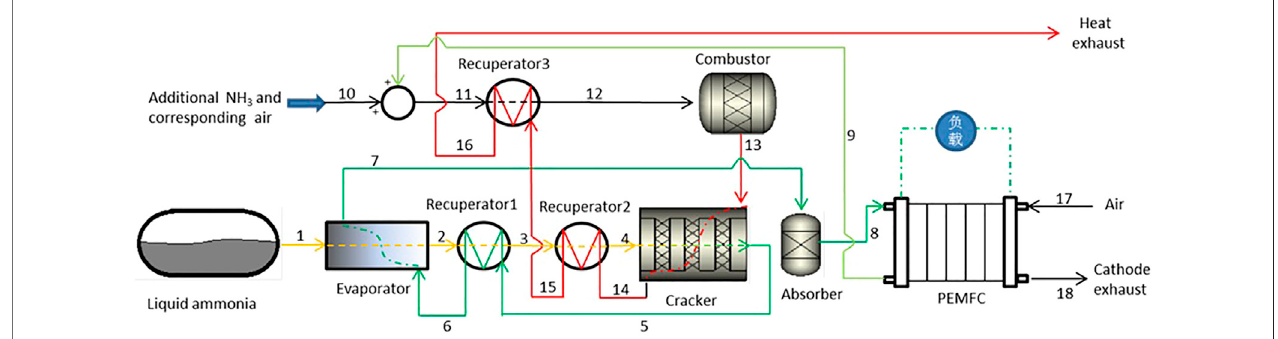
FIGURE 1 | System structure and